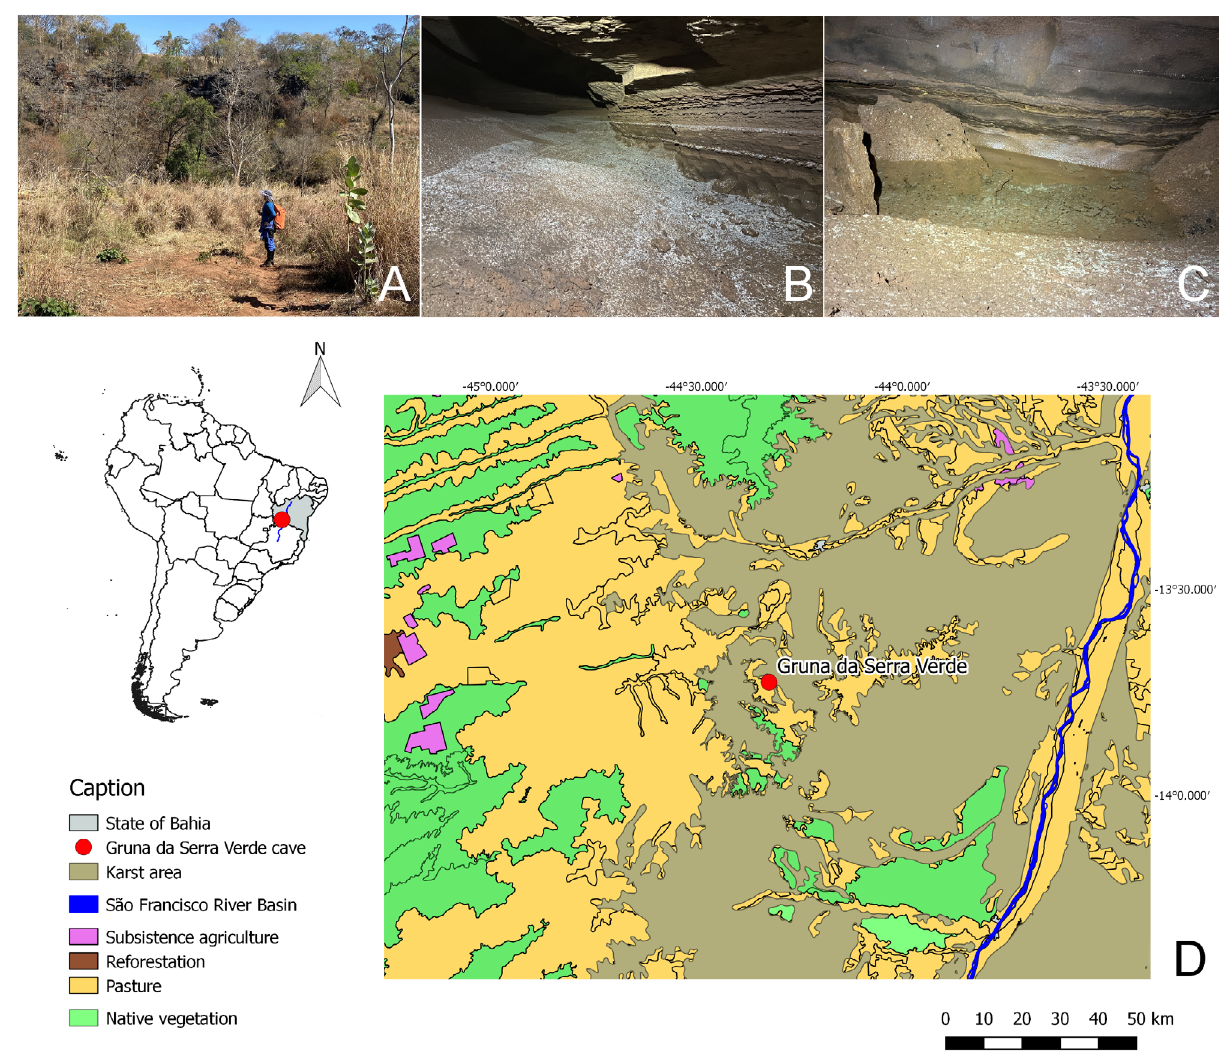
Figure 5. Outcrops and pastures close to the Gruna da Serra Verde cave ( A ); cave gallery in the dry season ( B ) and detail of the small pool formed by the upper phreatic aquifer, where specimens of Spelaeogammarus ginae sp. nov. were found ( C ); map indicating the state of Bahia, the Gruna da Serra Verde cave, and the land use and land cover of the area ( D ). Photographs: M.E.